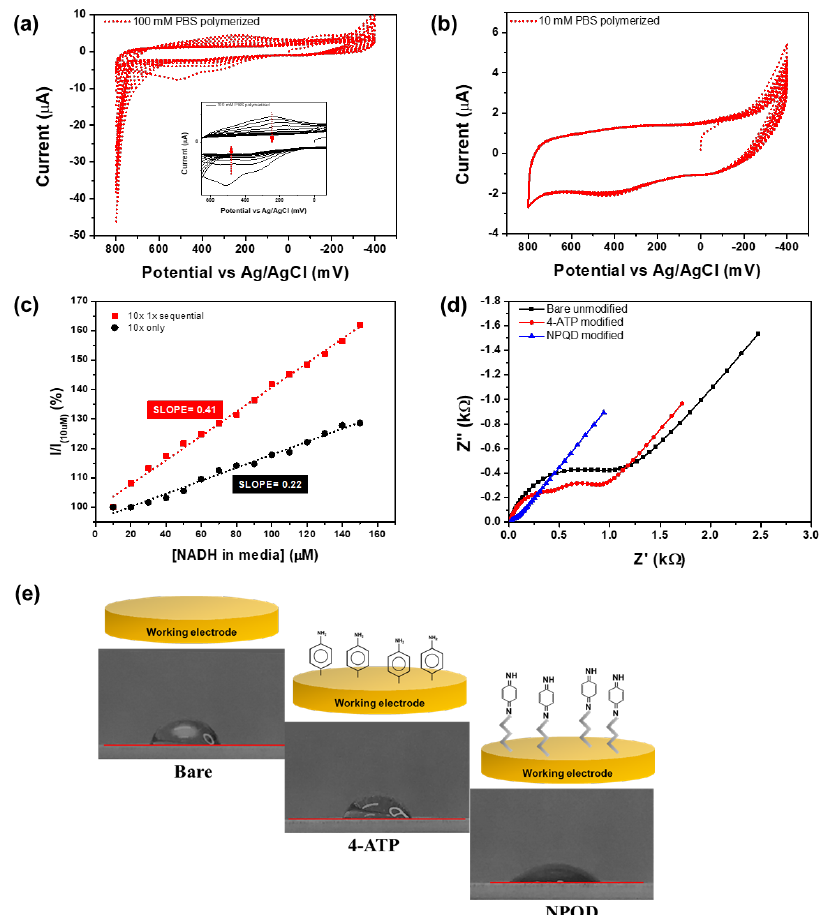
Figure 1. CV data during the electrochemical functionalization of the 4-ATP-Au electrode in: ( a ) a 100 mM PBS (pH 7.4); and ( b ) 10 mM PBS (pH 7.4) after ( a ). The scan rate is 100 mV/s; ( c ) NADH detection with double-step polymerized and single polymerized; ( d ) Nyquist plot of each electrode; ( e ) contact angle measurement of each electrode.